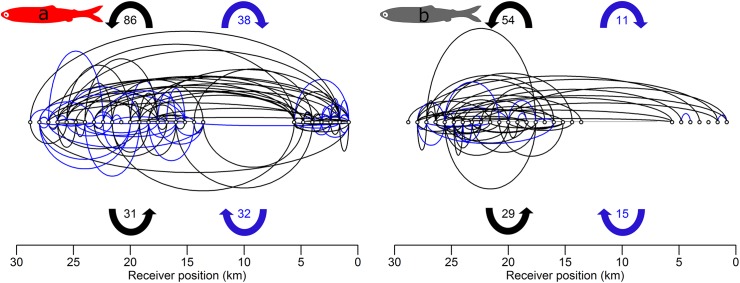
Visual representation of lateral movements taken by sockeye (a) and steelhead (b) smolts.Open circles represent the 27 receivers at the northern Strait of Georgia (NSOG) array. Lines indicate counterclockwise (black) or clockwise (blue) movements by individual smolts between either the first and second detection sequence (above receivers) or between the second and third sequence (below receivers). Line length is set equal to a distance travelled assuming each smolt swims continuously at 1 BL/s for the entire time duration between detection sequences. This distance (half of an ellipse’s perimeter) was used to estimate the vertically-oriented radius of the ellipse for plotting purposes using Ramanujan’s first approximation [44]. Vertical scale (not shown) is equal to horizontal scale. Ellipses were drawn using the plotrix package [45] in R [42]. Smolts exhibiting linear migration routes (see Materials and Methods) are not shown.